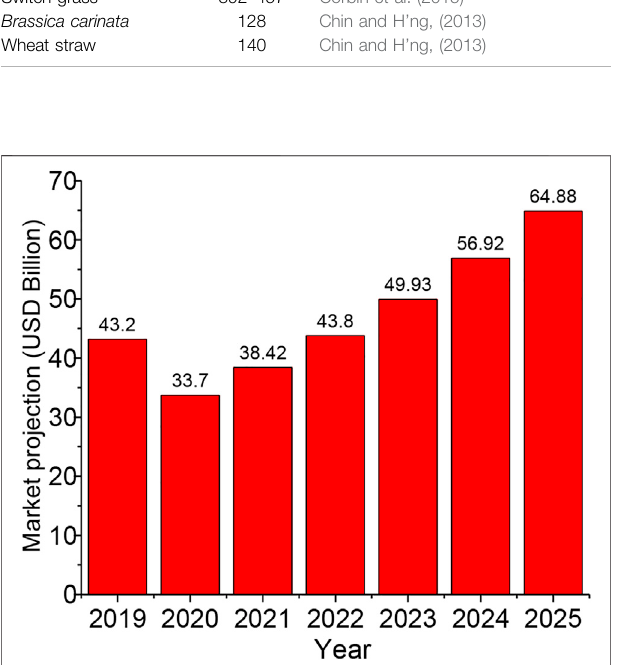
FIGURE 8 | Yearly global size projection of bioethanol